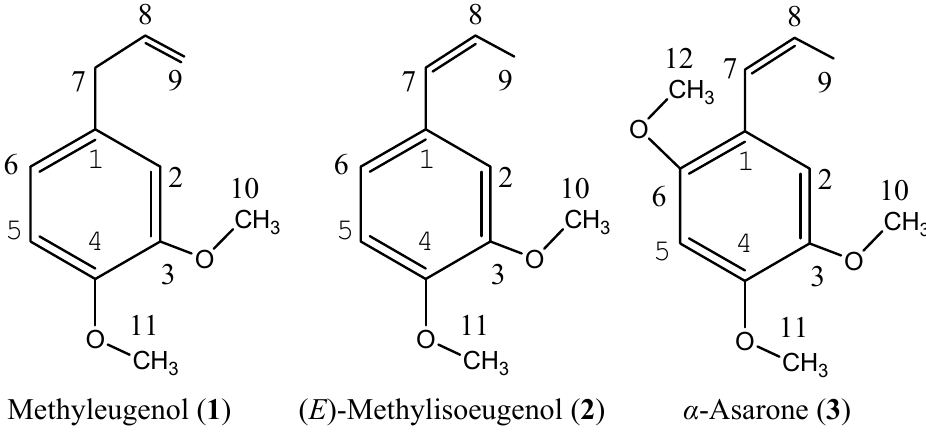
Figure 1. Main constituent compounds isolated from the essential oil of A. calamus